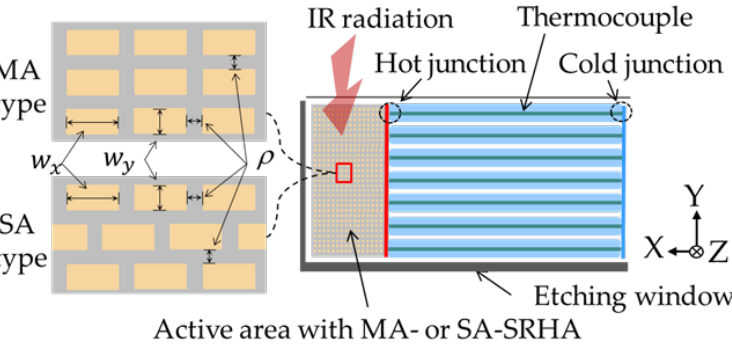
Figure 1. Sketch of the complementary-metal-oxide-semiconductor (CMOS) compatible thermopile and top-view sketches of matrix arrangement-subwavelength rectangular-hole arrays (MA-SRHA) and staggered arrangement-subwavelength rectangular-hole arrays (SA-SRHA) shown in two sub-graphs.